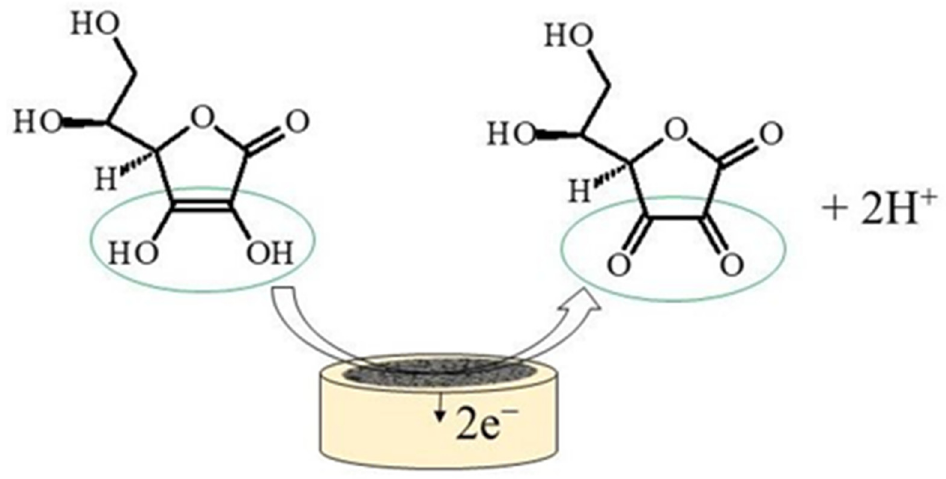
Figure 1. Electrocatalytic oxidation of ascorbic acid. Chronoamperometry and voltammetric techniques—cyclic voltammetry (CV), differ- ential pulse voltammetry (DPV), and square wave voltammetry (SWV) (Figure 2) can